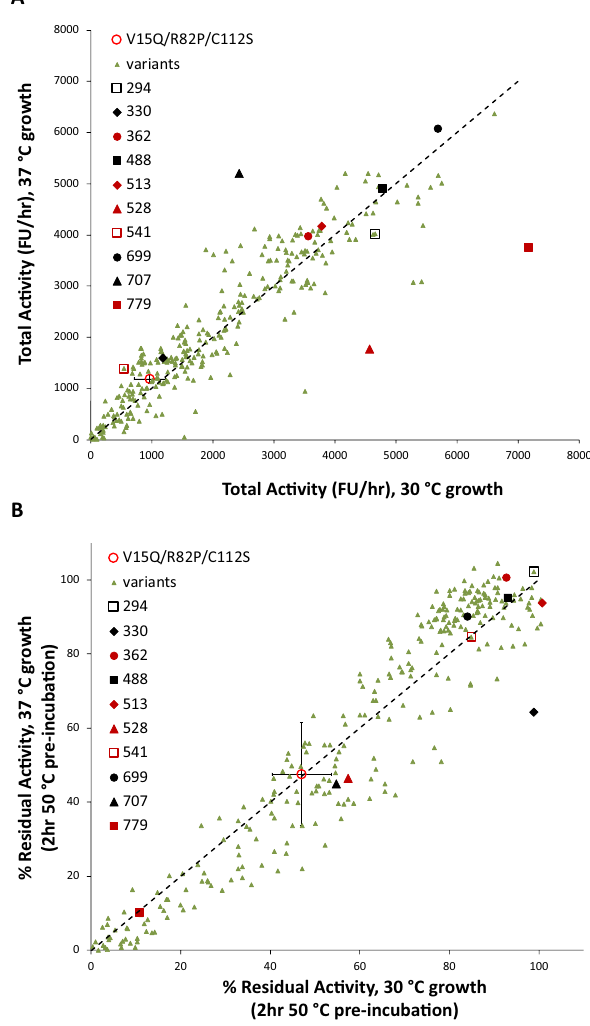
Figure 4. Total activities and stabilities of 321 EK L variants from retest assays. V15Q/R82P/C112S (red open circle with standard deviation error bars) was assayed in triplicate whereas the rest were assayed in singlicates. ( A ) Comparison of total activities for the variants expressed at 30 °C and 37 °C. ( B ) Comparison of residual activities after a 2-h heat inactivation at 50 °C, for the variants expressed at 30 °C and 37 °C. Interesting EK L variants are highlighted with larger symbols and noted in the figure